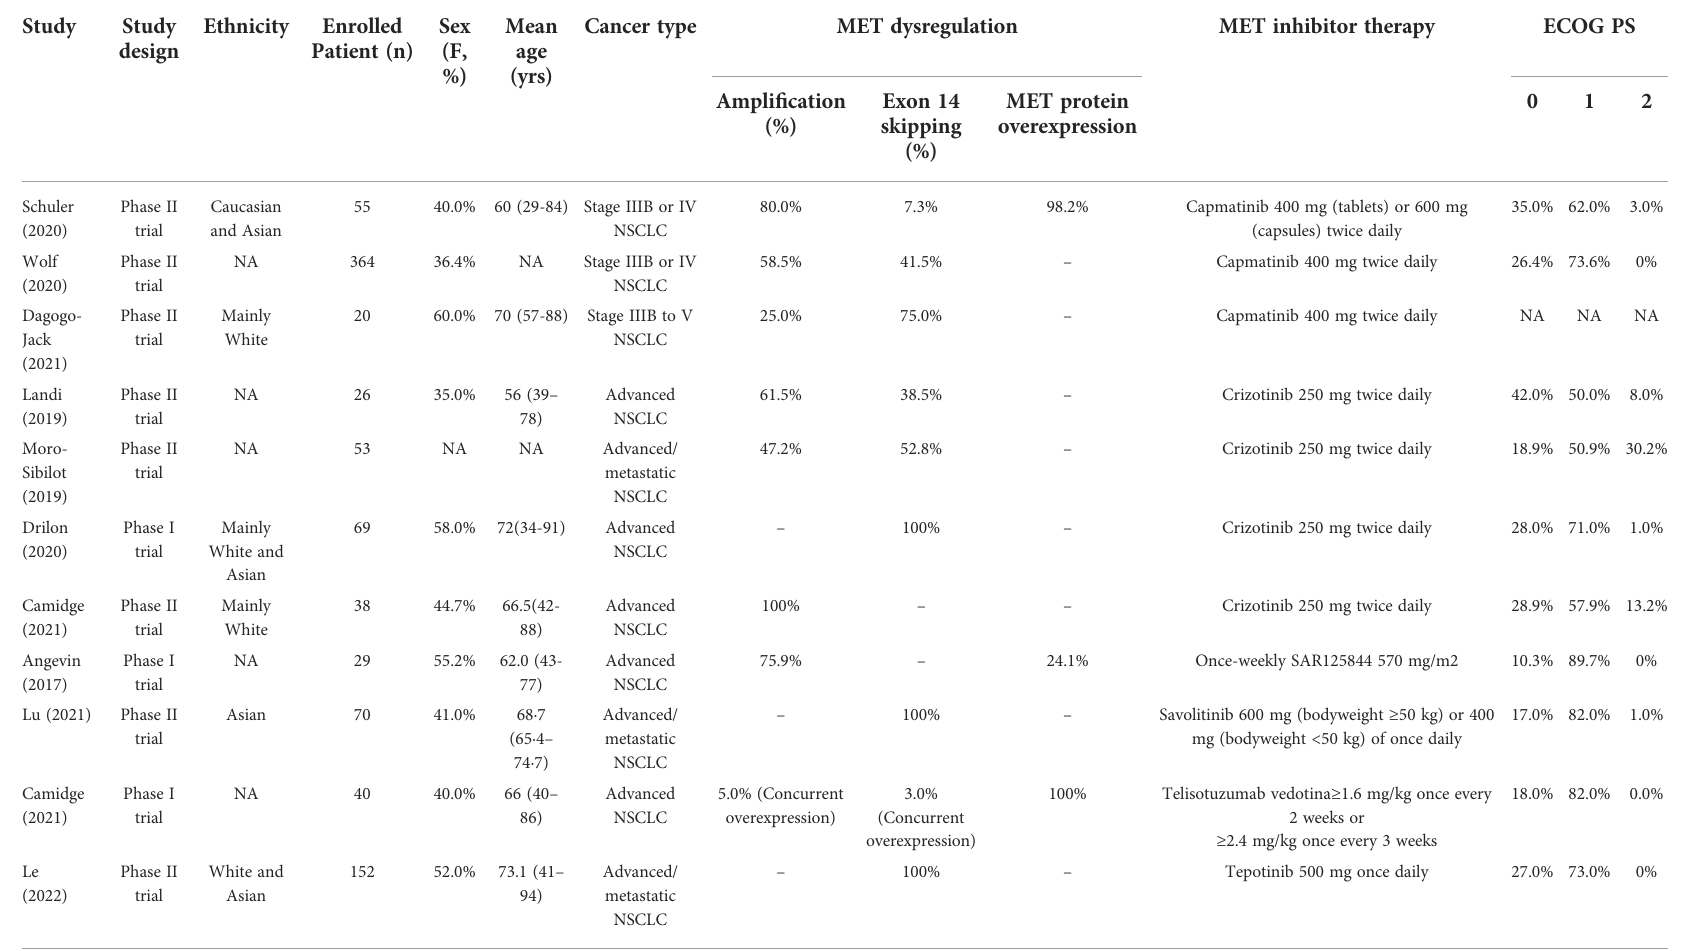
TABLE 1 Baseline clinical characteristics of included